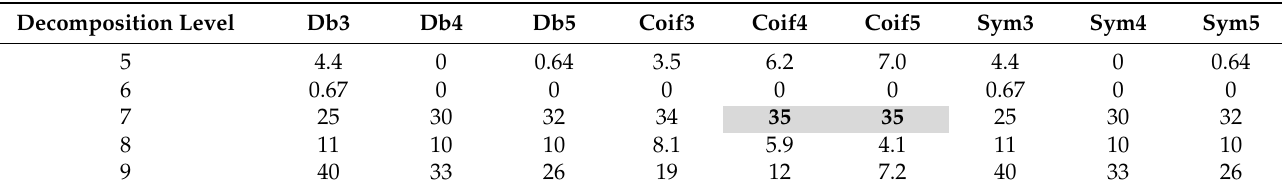
Table 1 lists DW values for representative wavelets and decomposition levels 5 – 9. Table 1. DW values for (Daubechies, Coiflets, and Symlets). Decomposition Level